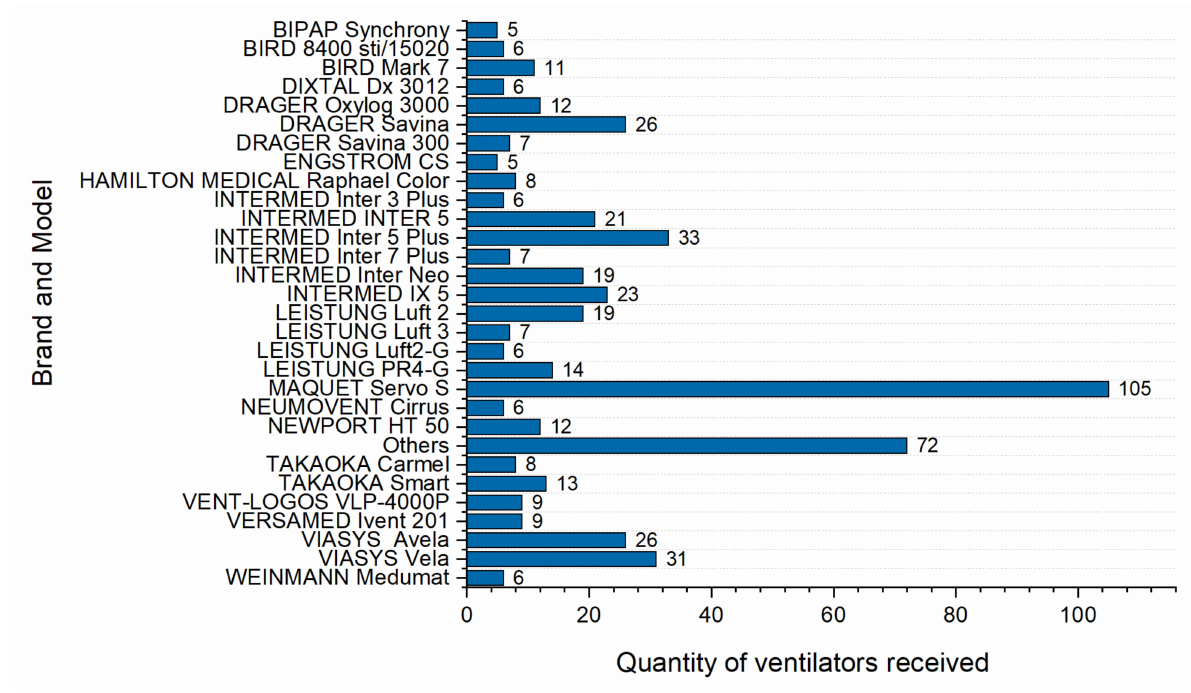
Figure 12. Number of ventilators received by brand and model at the Reference